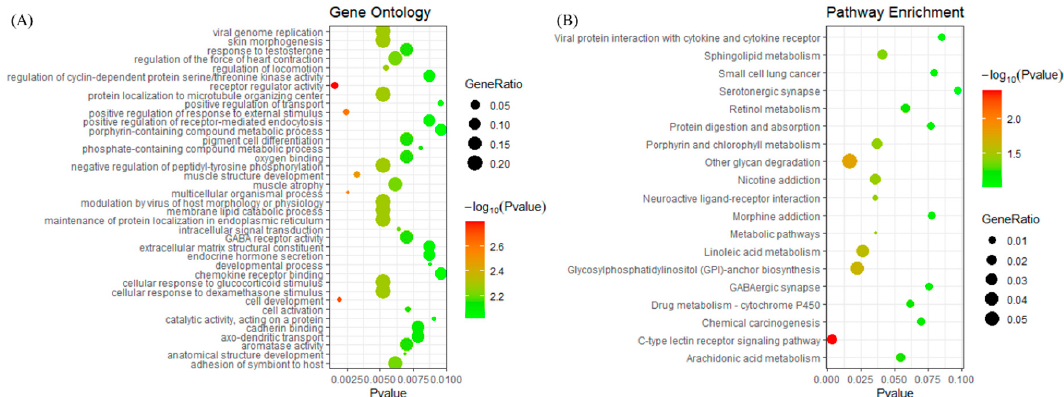
Figure 4. The enrichment analysis for the 34 DEGs. ( A ) The bubble diagram of the enriched gene ontology. The vertical axis represents the enrichment functions, and the horizontal axis showed the corresponding p -value, which is below 0.01. ( B ) The bubble diagram of the enriched Kyoto Encyclopedia of Genes and Genomes (KEGG) pathways. The vertical axis represents the enrichment pathway, and the horizontal axis shows the corresponding p -value, which is below